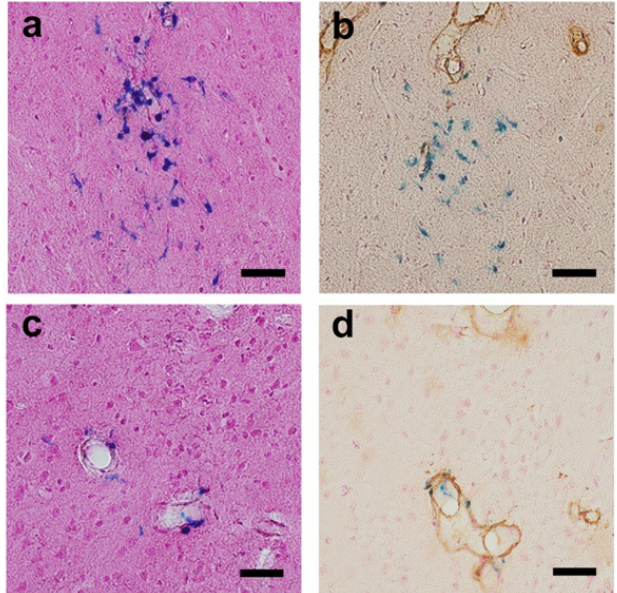
Figure 3. Representative images of cerebral micro-hemorrhage findings (a, b, Perls’s Berlin blue stain with Nuclear Fast Red (Kernechtrot stain solution)); b, d, double-labeled for amyloid (brown) and hemosiderin (blue)). ( a ) Clusters of hemosiderin staining are shown in the brain parenchyma (cortex at 1.35 mm behind Bregma). ( b ) In an adjacent section to a, some of them are in contact with amyloid- β (Aβ) -positive vessels. ( c ) Localized hemosiderin shown around the vessel wall (cortex at 0.85 mm behind Bregma). ( d ) In an adjacent section to c, localized bleeding to amyloid-laden vessels is shown. Scale bars indicate 10 µ m.